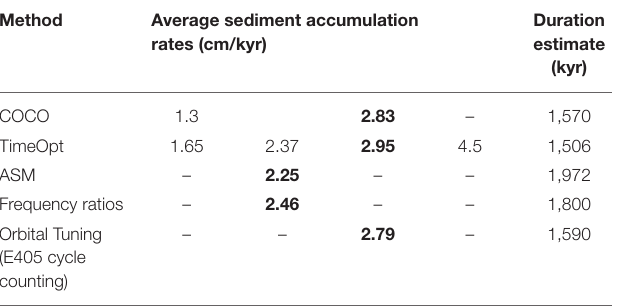
TABLE 2 | Summary of sedimentation rates and durations calculated by the different used methods (see Methods, section Astronomical Target